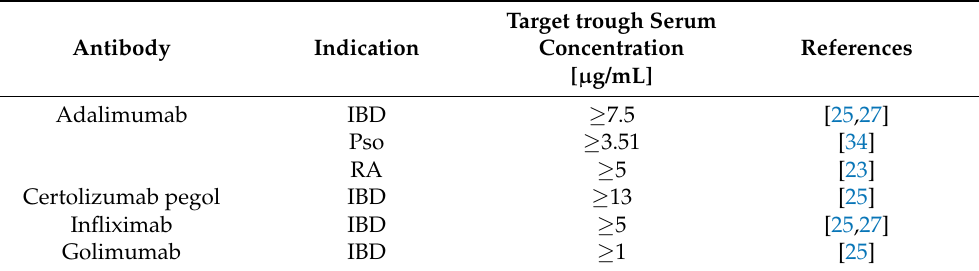
Table 1. Recommended target trough serum concentrations associated with the favorable outcomes in the maintenance phase for common monoclonal antibodies in inflammatory diseases. Target trough Antibody Indication